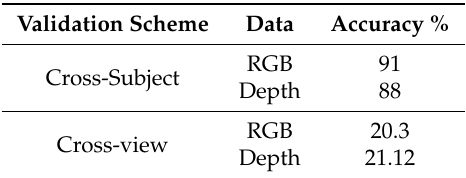
Table 1. Recognition accuracy in terms RGB and depth data of the Northwestern-UCLA (NUCLA) dataset using pre-trained AlexNet